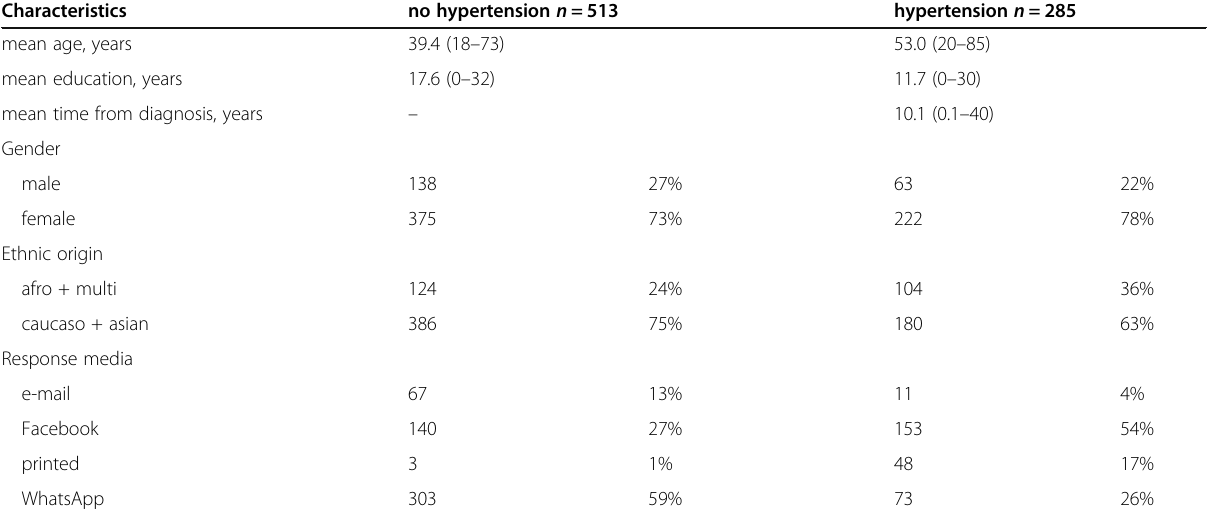
Table 2 Population